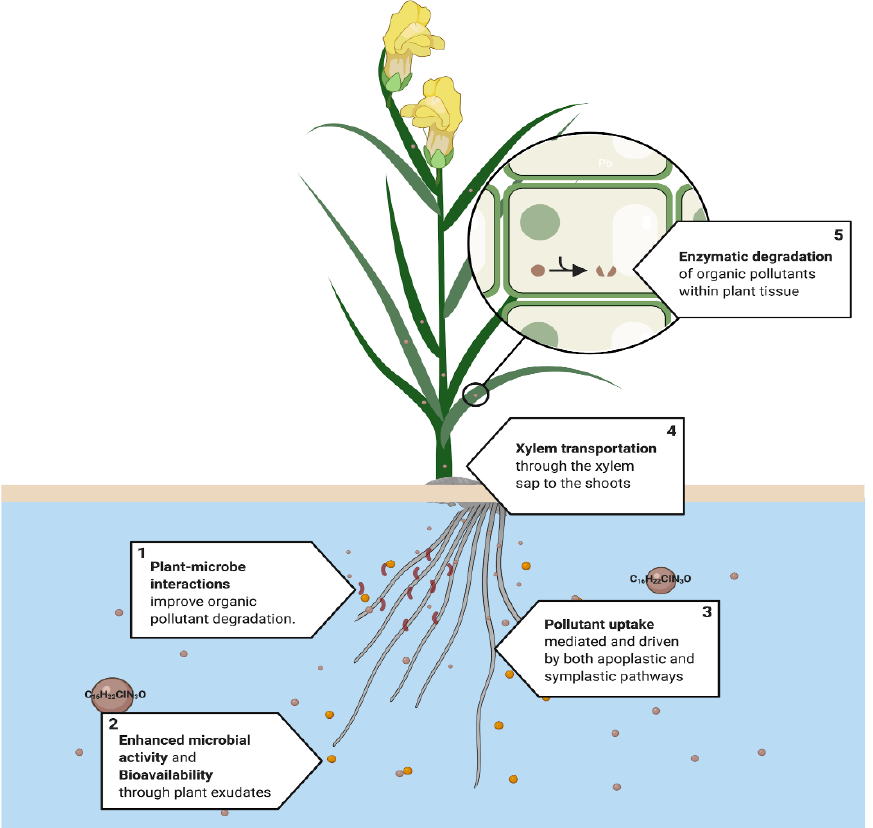
Figure 5. Proposed phytodegradation system. This process is used mainly in the phytoremediation of organic pollutants, such as tebuconazole C16H22CIN2O. (1) Plant–rhizosphere interactions improve the degradation of organic pollutants. (2) Root exudates increase the bioavailability and enhance rhizospheric activity, (3) followed by pollutant uptake, which occurs in the roots and is mediated by apoplastic and symplastic pathways. (4) Then, organic pollutants can be transported to mainly leaves or the roots through the xylem sap to finally (5) be metabolized in the cell to less toxic compounds by the action of plant enzymes. [111,112,120,121].